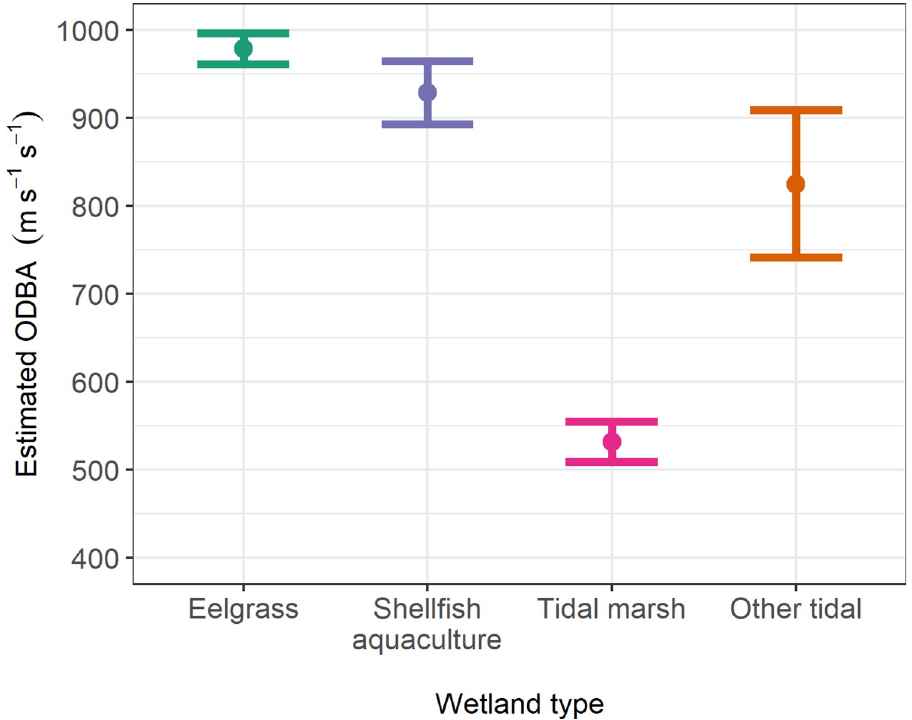
Fig 4. Overall dynamic body acceleration (ODBA) by seven GPS tagged great egrets in different tidal wetland types at Tomales Bay, CA, 2017–2019. Estimates and 95% profile likelihood confidence intervals are from a linear mixed effect model with bird ID included as a random